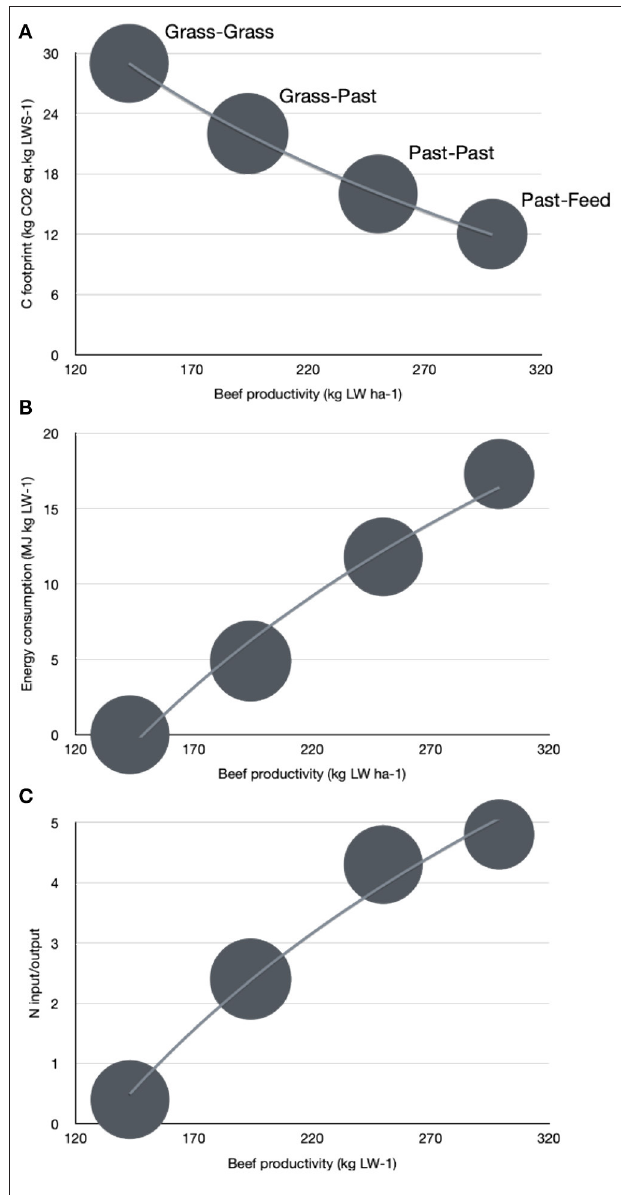
FIGURE 1 | Calculations of environmental footprints of four representative beef production system types in Uruguay varying in their intensity during the backgrounding and finishing phases, using native grasslands (Grass), sown pastures (Past), or feedlots (Feed). Carbon footprint (A) , energy consumption (B) , and nitrogen inputs (C) are plotted against average beef productivity per hectare per year. The size of the circles represents the average CO 2 emission rate per hectare per year. Grass-Grass indicates that both the backgrounding and finishing phases are done on native grasslands, Grass-Past indicates backgrounding on grasslands and finishing on pastures, and so on. The graphs were drawn using calculations presented by Picasso et al.